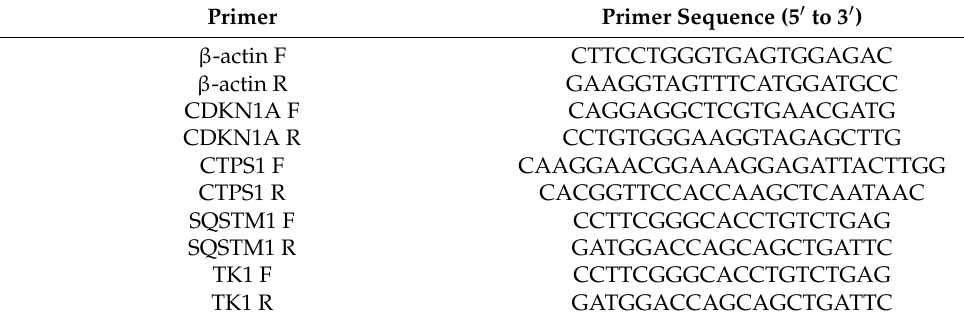
Table 1. Oligonucleotide primers used for RT-qPCR. Primer Primer Sequence (5 (cid:48) to 3 (cid:48)